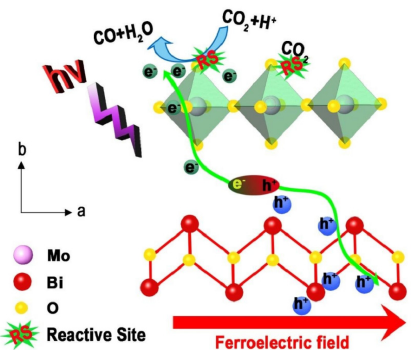
Figure 21. Schematic diagram of ferroelectric field-assisted photocatalysis of Bi 2 MoO 6 (Reprinted/adapted with permission from Ref. [223]. Copyright 2020, copyright Royal Society of Chemistry).